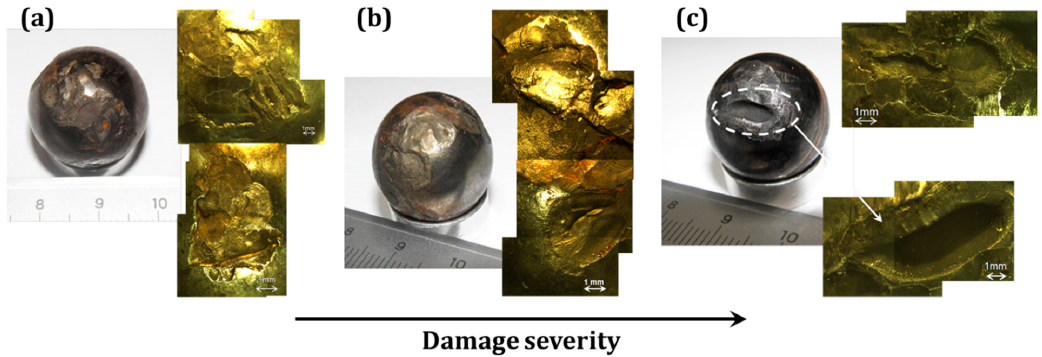
Figure 6. Representative failed rolling balls exhibiting different levels of damage severity.